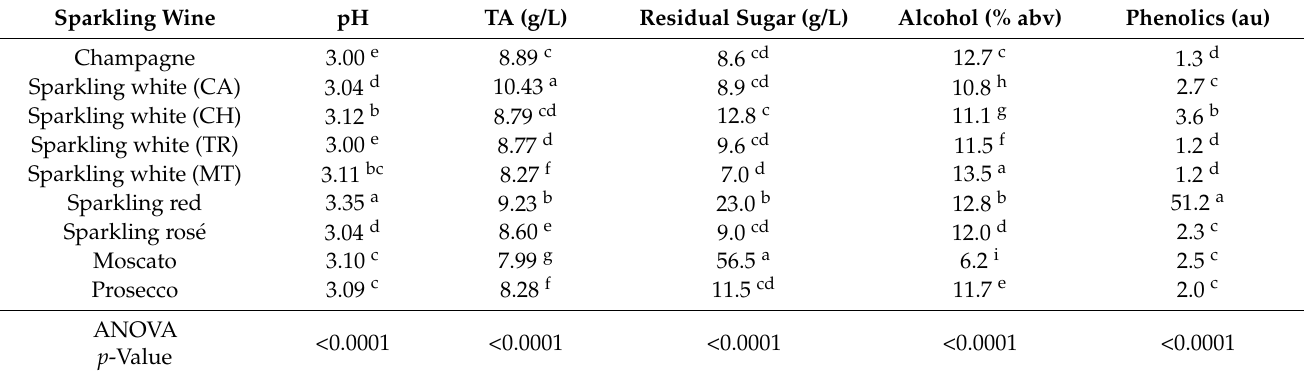
Table 2. Basic chemistry of the French Champagne and Australia sparkling wines studied.